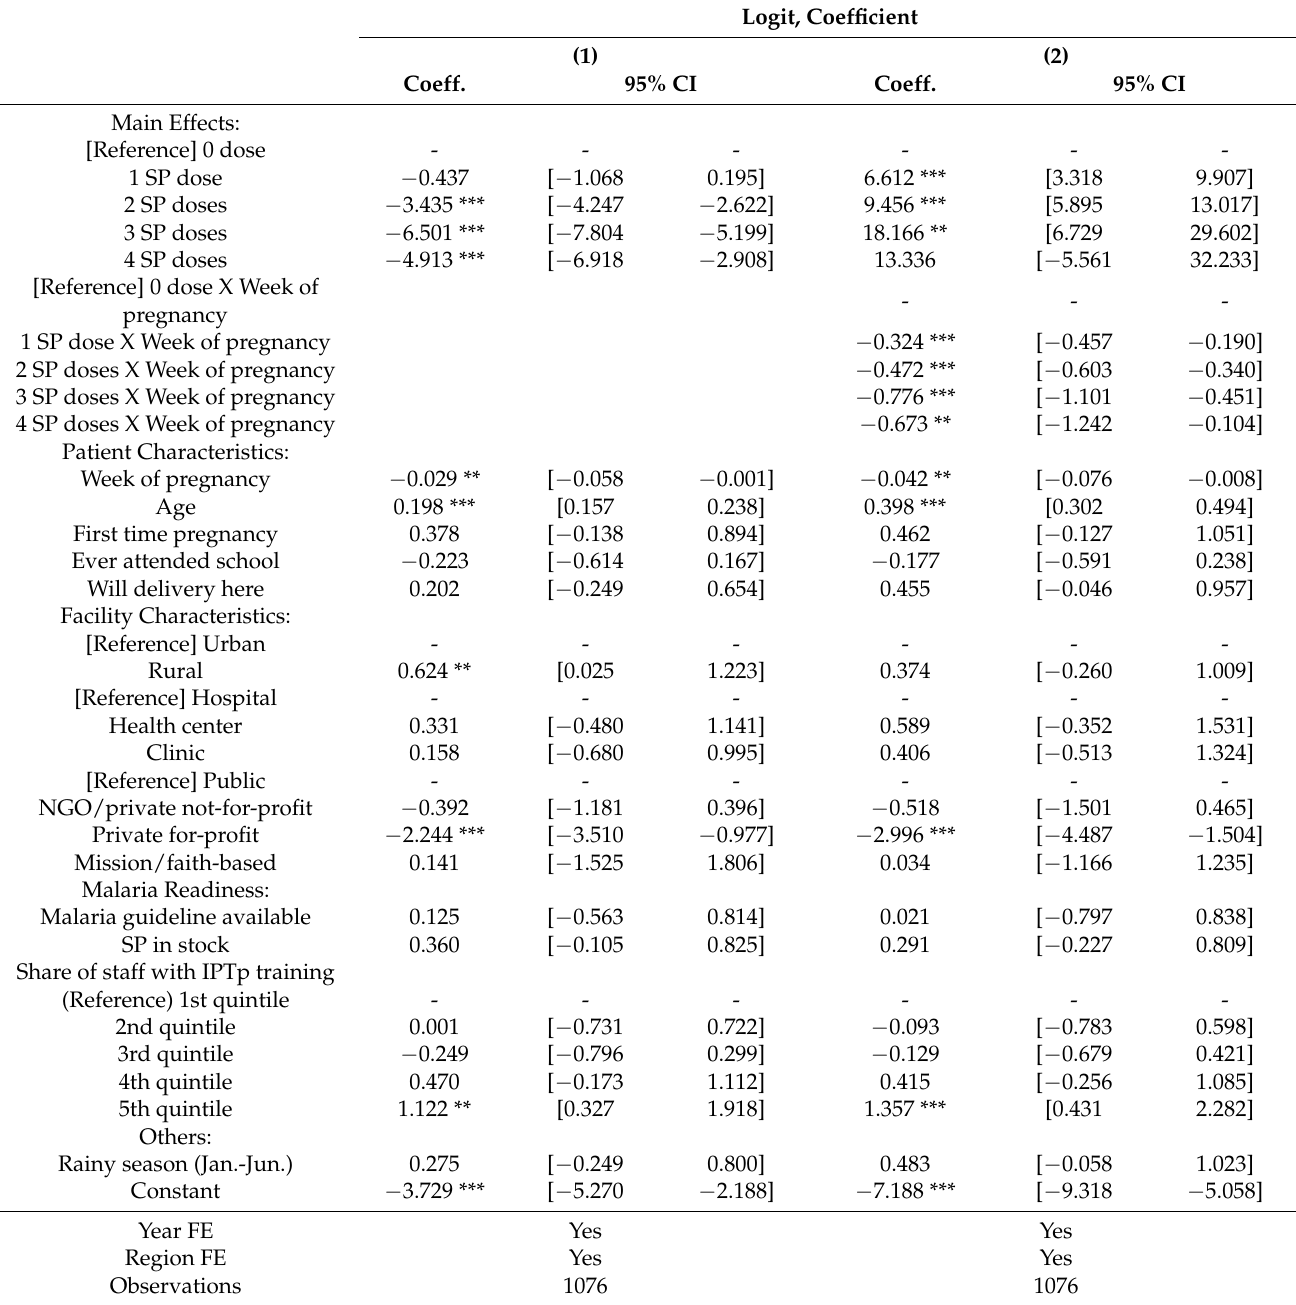
Table A3. Logit Regression Results,